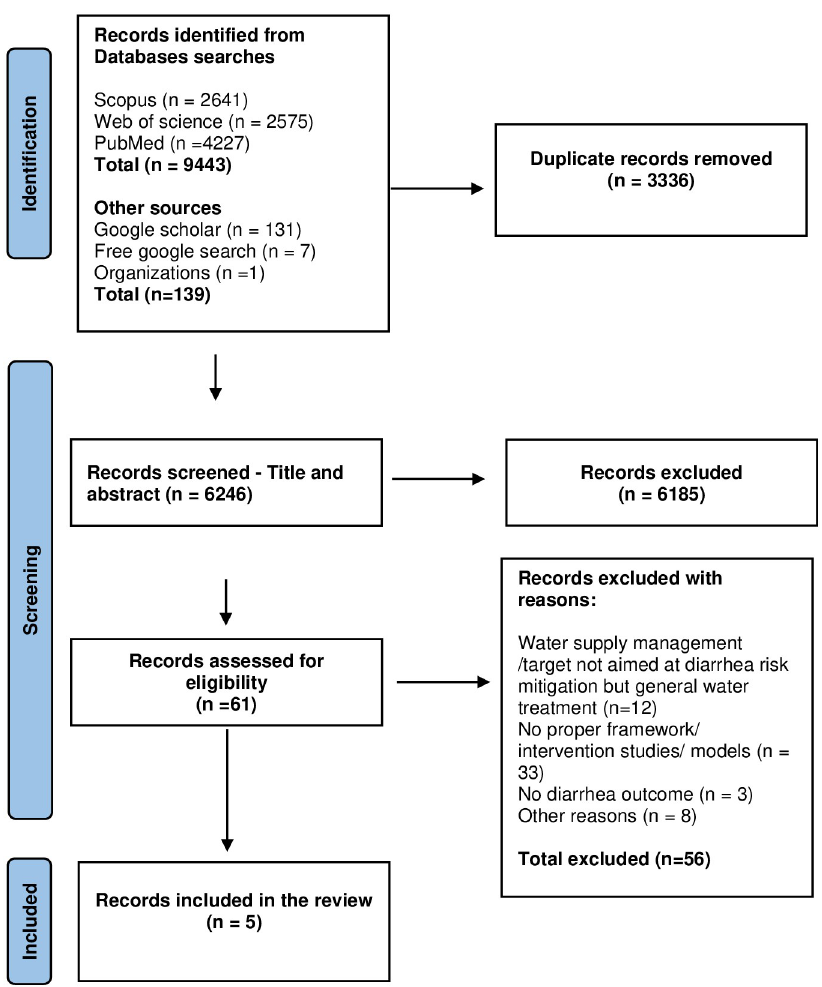
Fig 1. PRISMA diagram for scoping review of frameworks for mitigating the risk of waterborne diarrheal diseases.